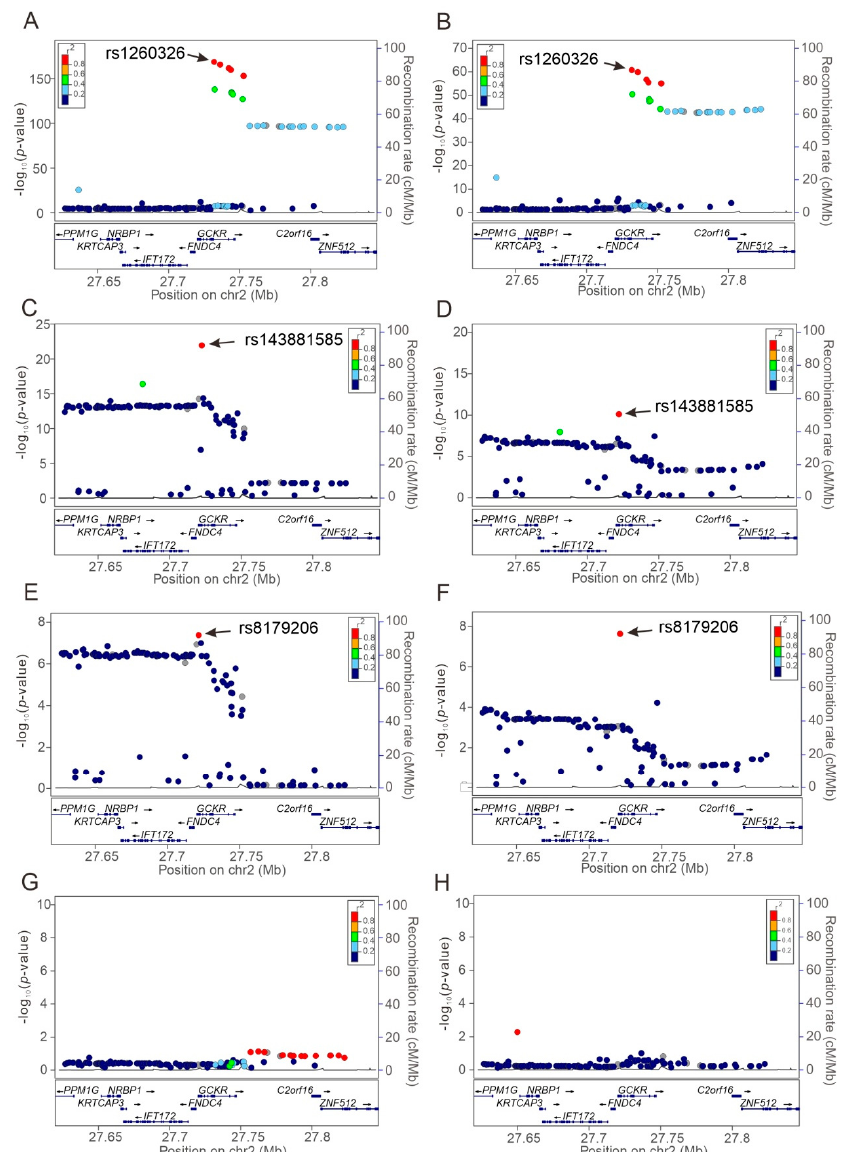
Figure 2. Regional plot associations of the GCKR gene region for the serum triglyceride and albumin levels. Regional plot associations are shown without ( A , B ) or with serial conditional analysis after further adjustment for rs1260326 ( C , D ), rs143881585 ( E , F ), and rs8179206 ( G , H ) genotypes. Association analyses were performed for serum triglyceride ( A , C , E , G ) and albumin ( B , D , F , H ) levels. GCKR , glucokinase regulator.